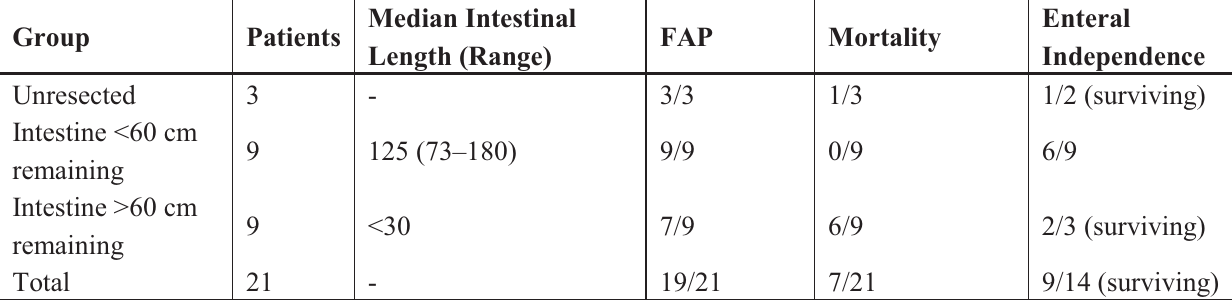
Table 2. Summary of outcomes in patients with advanced intra-abdominal desmoid